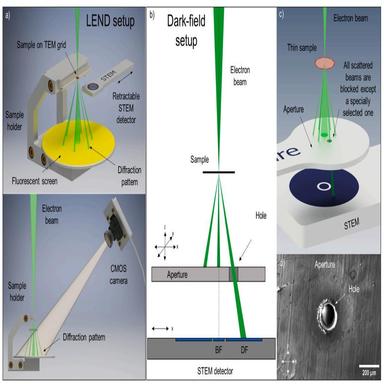
Basic principle and setup of the aperture-based dark-field STEM method. a) Original LEND setup with retractable STEM detector et al., 2020). b, c) Aperture-based dark-field setup shown in side view (b) and bird's eye view (c). The fluorscence screen located under the STEM detector is not shown for simplicity. The aperture inserted between the sample and the STEM detector blocks all scattered electrons except the selected Bragg reflection which passes through and reaches the ADF detector. d) Opti